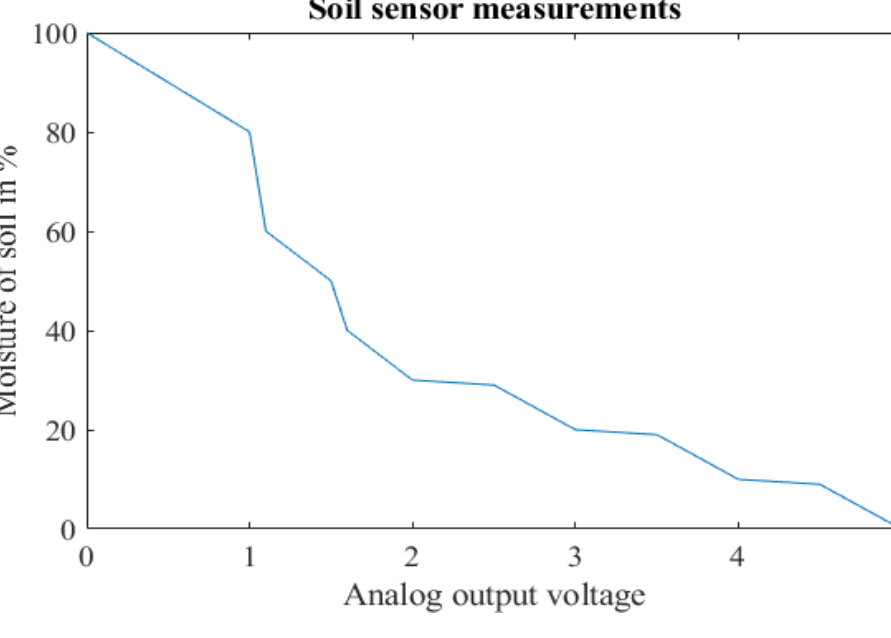
Figure 13. Results of soil moisture measured in percentage against output voltage. The linear behavior between the volume of water and ADC output values is shown in Figure 14.